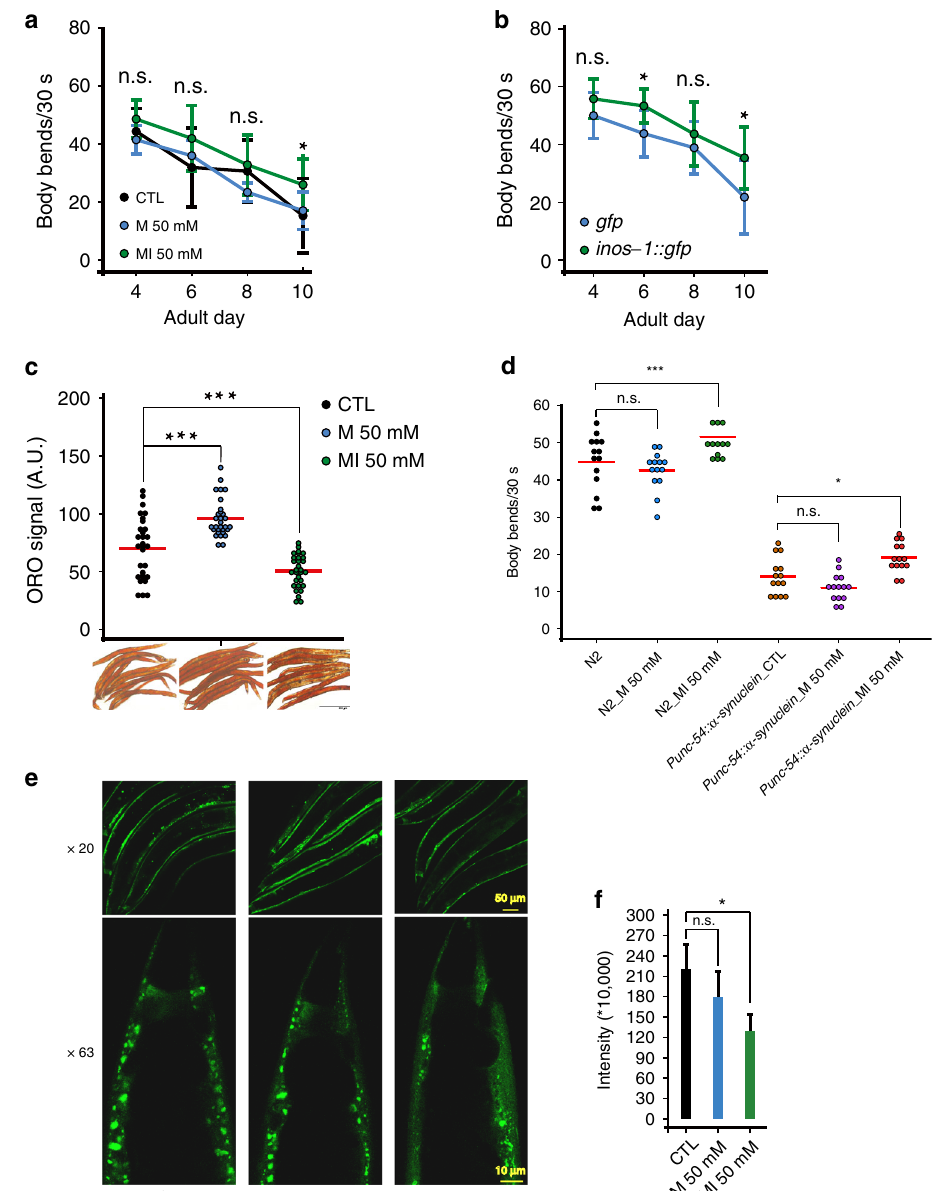
Fig. 2 MI supplementation alleviates worm health decline during aging. a 50 mM MI alleviated worm mobility decline from AD_4 to AD_10 (Data are presented as mean values ± SEM, n = 10, two-sided t -test * p < 0.05 on AD_10), N = 2. b inos-1 OE alleviated worm mobility decline (Data are presented as mean values ± SEM, n = 10, two-sided t -test * p < 0.05 on AD_6 and AD_10), N = 2. c ORO staining shows MI suppressed worm fat storage on AD_10 ( n = 30, two-sided t -test *** p < 0.001), N = 6. d MI p romoted the mobility of the worm model of PD ([ unc-54p:: α -synuclein::YFP + unc-119( + ) ] ( n = 14, two- sided t -test * p < 0.05), N = 3. e Representative images show MI supplementation decreased α -SYNNUCLEIN::YFP aggregates in this PD model (20× labels images under 20x microscopy, scale bar 50 μ m; 63× for 63x microscopy scale bar 10 μ m). f Quanti fi cation of Fig. 2e like worms but on one worm tail region per image, under 63x CONFOCAL microscopy (Data are presented as mean values ± SEM, n = 30, two-sided t -test * p < 0.05), N = 2. Source data are provided as a Source Data fi